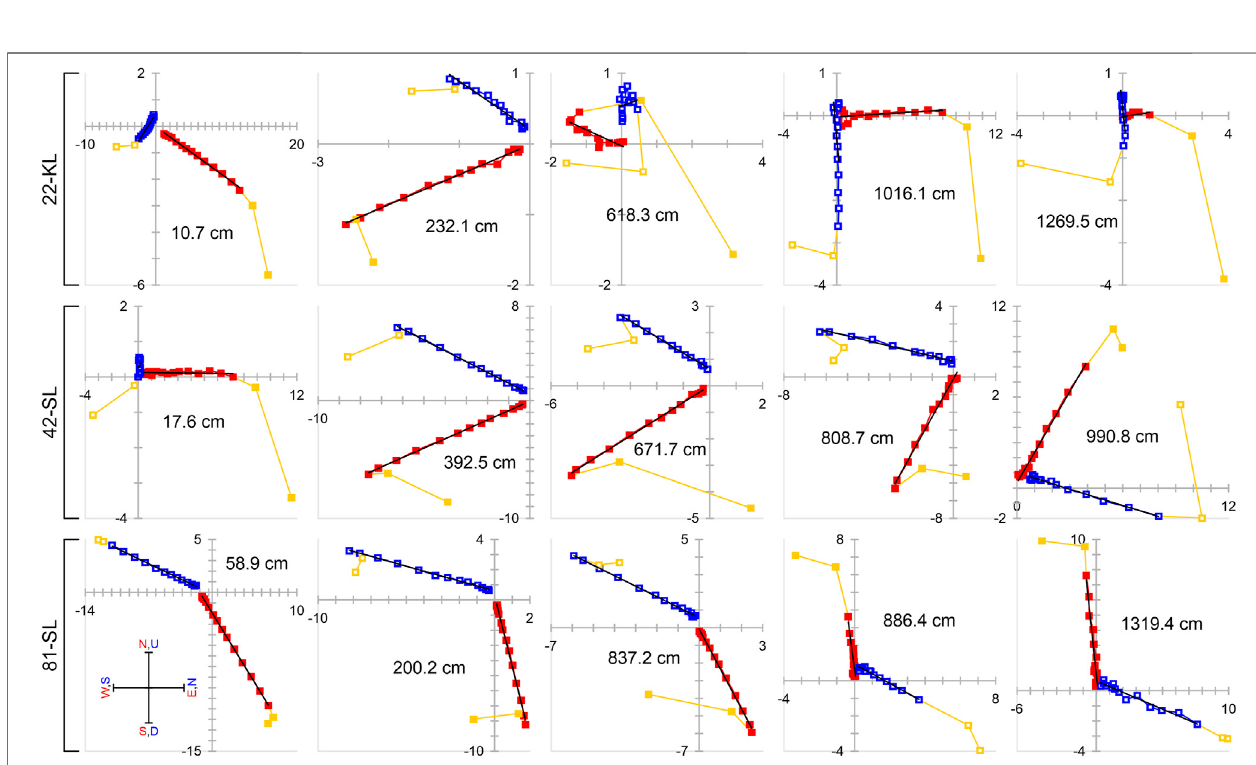
FIGURE 4 | Selected Zijderveld NRM demagnetization plots (units in mA/m) for all three cores. Vertical projections are marked with blue open squares, horizontal projections with red fi lled squares. Yellow symbols mark magnetically overprinted components that were excluded by PCA. Linear regression fi ts point to the origin for most of the samples, but a small and systematic vertical offset is noticeable in most cases.